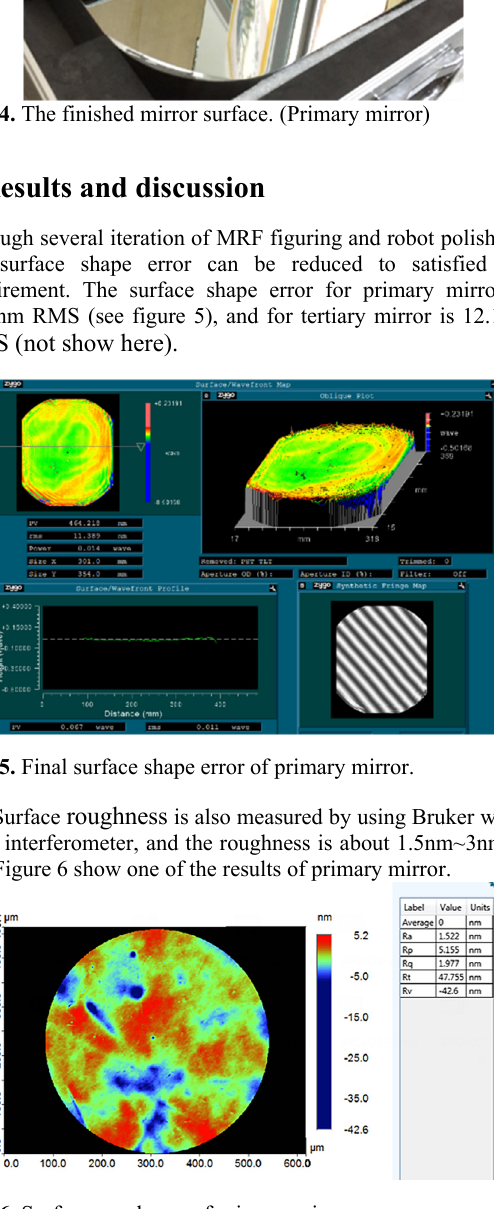
Fig. 6. Surface roughness of primary